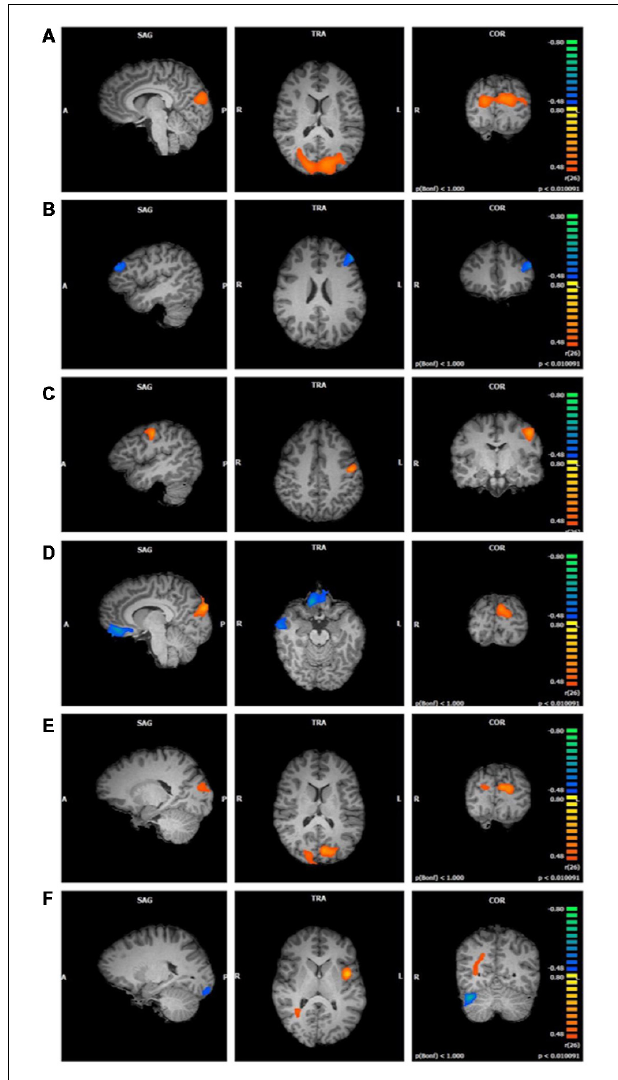
FIGURE 2 | Functional connectivity of salience network (SN) clusters correlated with trait mindfulness and five of its facets ( p < 0.01, cluster threshold estimator corrected). From top to bottom: (A) FFMQ Total ; (B) Observing ; (C) Describing ; (D) Acting ; (E) Non-Judging ; (F) Non-Reactivity